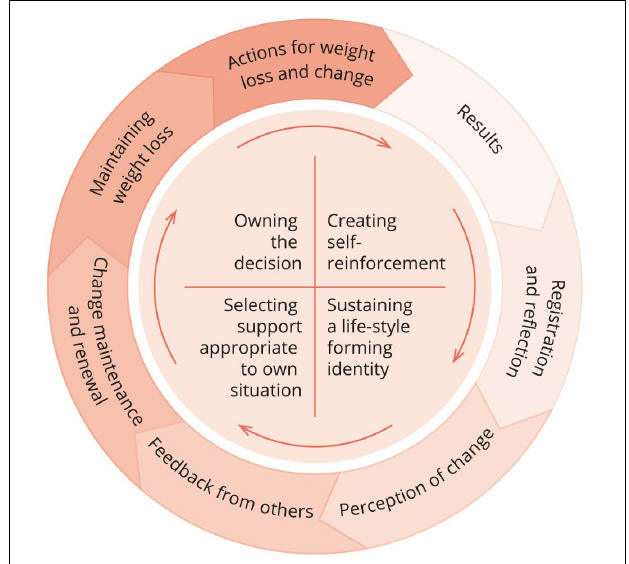
FIGURE 1 | Experientially derived model of weight loss maintenance after severe